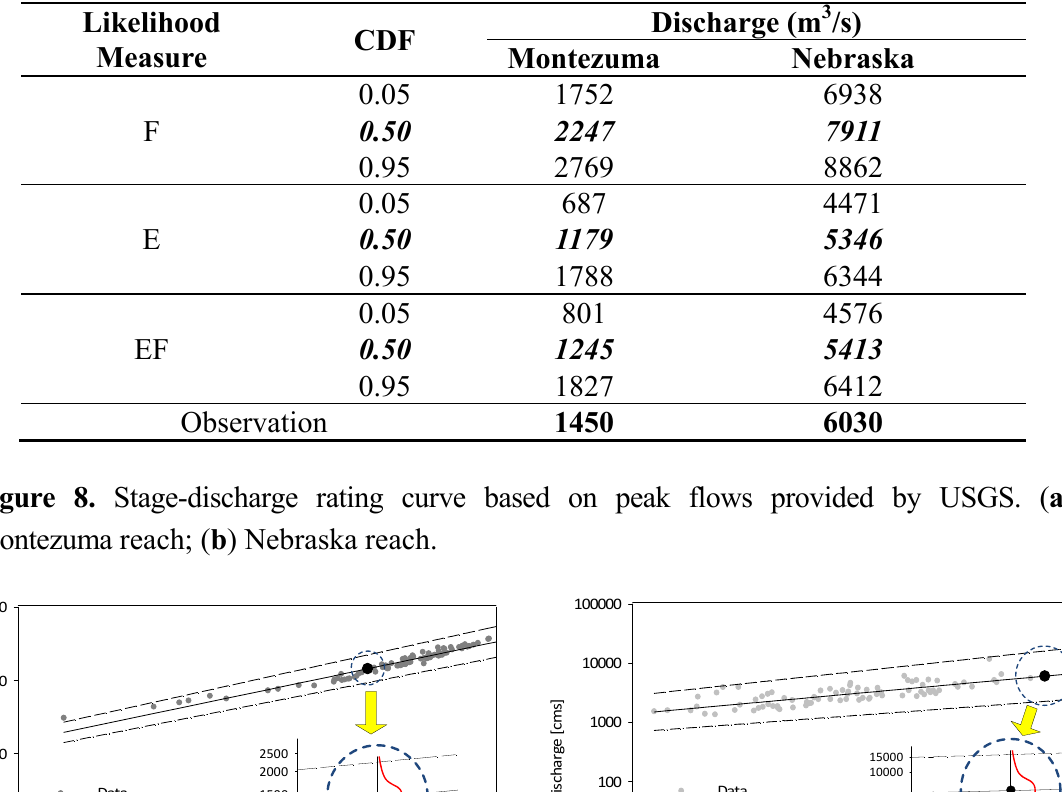
Table 4. Boundaries of the approximated discharge for each likelihood measures.